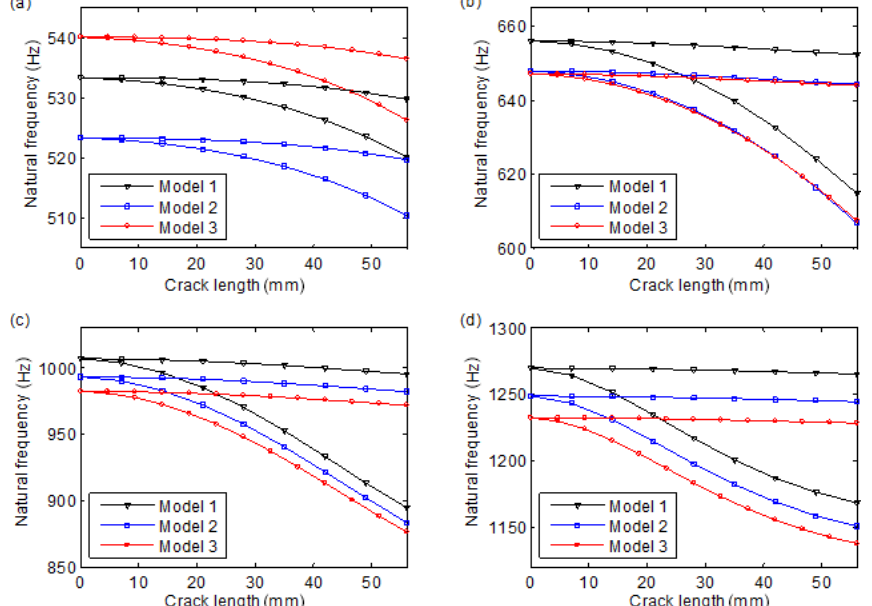
Figure 9. Variation of natural frequencies versus crack length: (a) 1ND, (b) 2ND, (c) 3ND and (d) 4ND. Models 1, 2 and 3 possess 4260, 6780 and 14400 nodes,